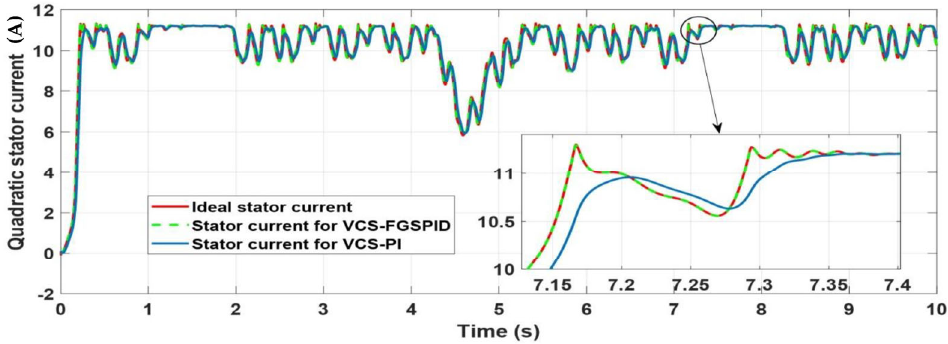
Figure 24. Stator current’s quadratic component.